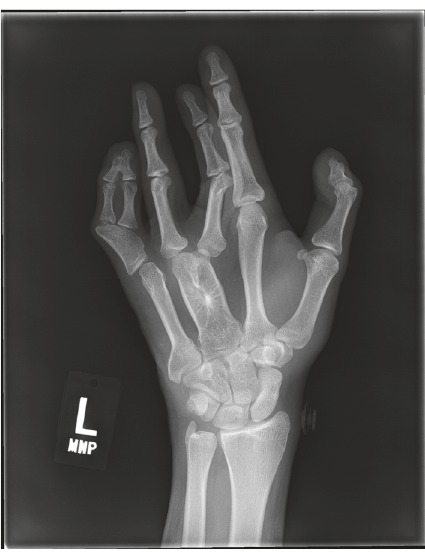
Figure 2: Hand X-ray exhibiting polysyndactyly of the 3rd and 4th metacarpals, and polydactyly of the middle and distal phalanges of the 5th finger. Subluxation of unknown age of the proximal phalanx of the 3rd finger was coincidentally